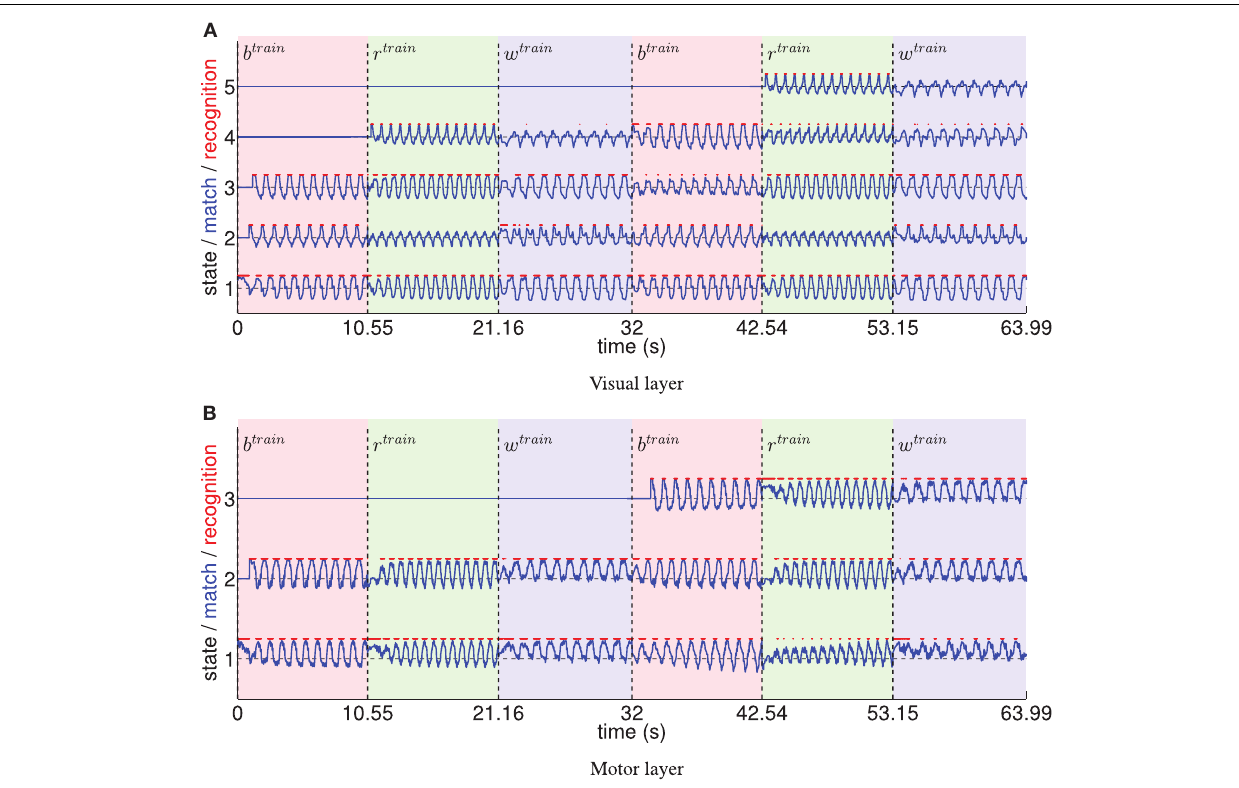
FIGURE 5 | (A) The systematic time series of prototype matches and resulting recognition signals of five visual states, developing during training with θ = 0.1. Three different, cyclic motion tracking trials were learned repeatedly during this procedure (the first two repetitions are shown). Light red patches tagged with b train indicate the time intervals the basketball training trial was shown, the light green patches r train indicate the intervals of the running trial, and the light blue patches tagged w train indicate training on the walking trial. It can be seen that the time series of prototype matches (blue lines) are comparable when re-enacting the presentation of a motion tracking trial, since cells learn to encode specific parts of the data. Because the movements were cyclic, also the determined visual states (red lines) formed cyclic time series. Initially, some state prototypes were recoded when another movement was shown. (B) Equivalent evaluation of the state cell development in the motor